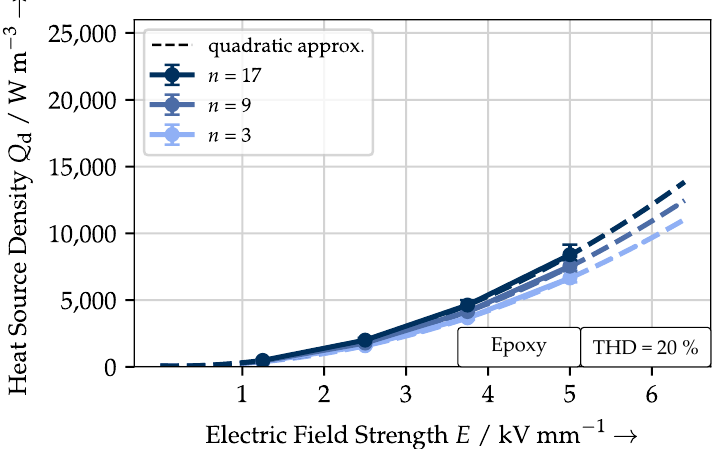
Figure 9. Heat source density of an epoxy polymer as a function of the electric field strength under distorted voltage THD = 20%, quadratic approximation for E = ( 1.25 ... 3.75 ) kVmm − 1 , the mean and range of three test